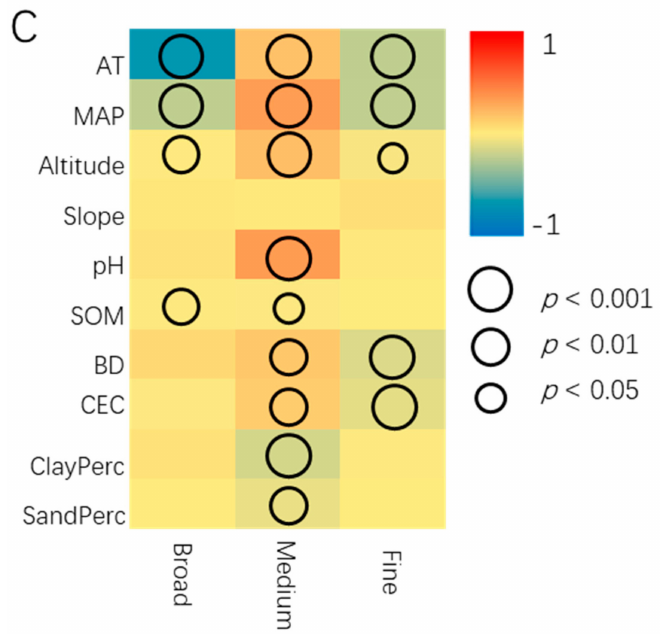
Figure 6. ( A ) Scale division of 63 significant dbMEMs, divided into broad, medium, fine; ( B ) the dbMEM display graph with the highest R 2 screened out from three different scales; ( C ) factor analysis graph based on the screened dbMEM. The squares in ( A ) represent dbMEM and the colors represent significance. ( B ) shows dbMEM, fitted at different scales; the circles represent the spatial structure and the colors represent positive and negative